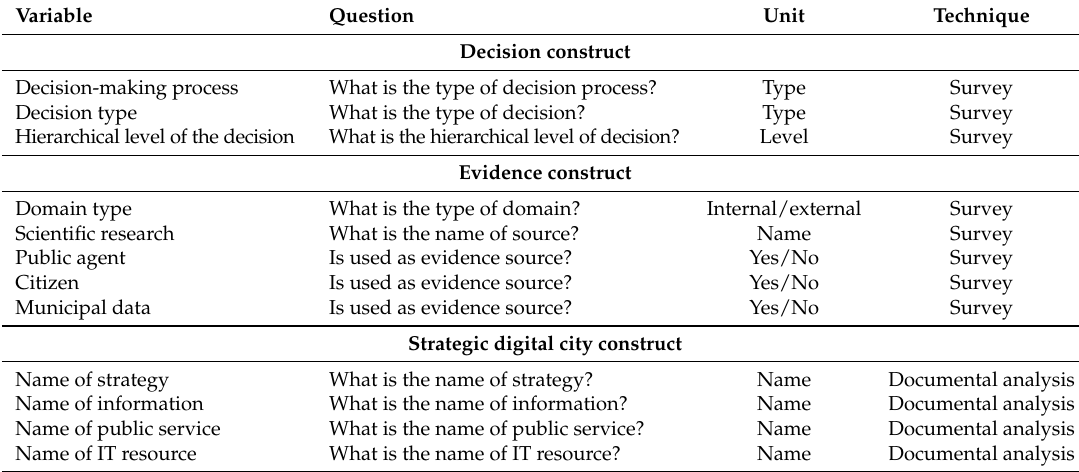
Table 1. Research protocol